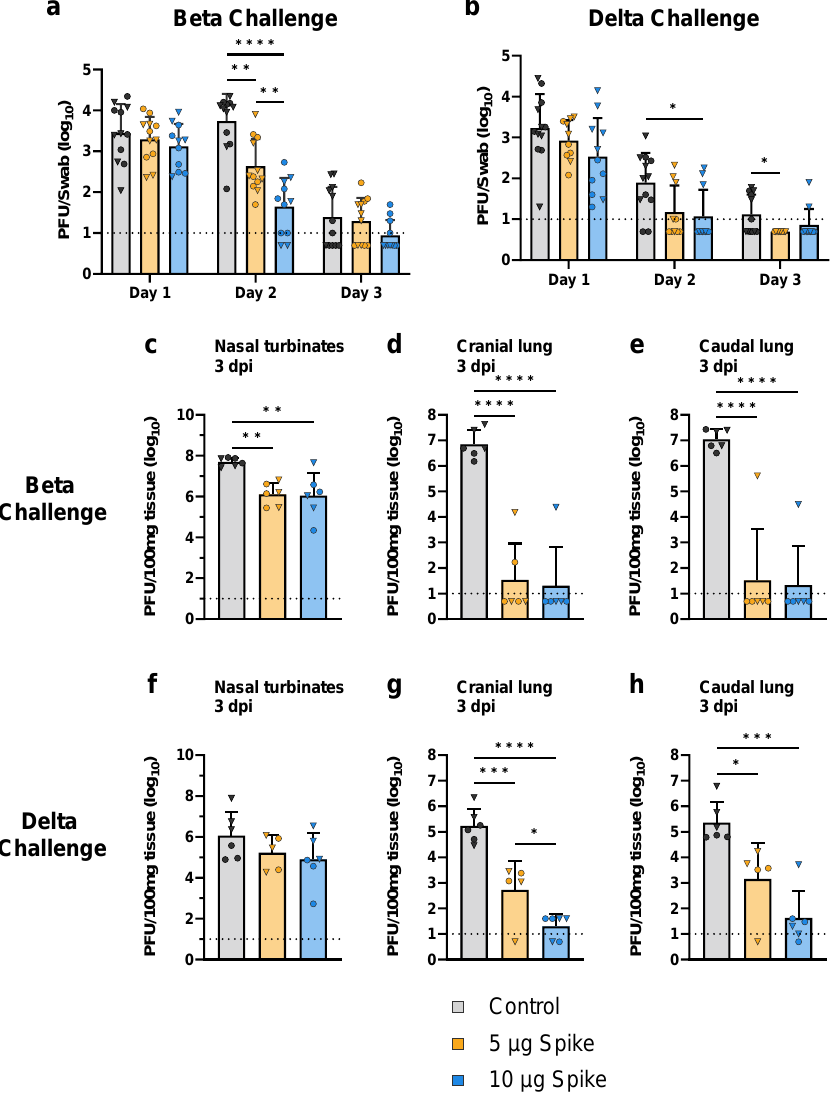
Figure 5. Viral load in the upper and lower respiratory tract after challenge with SARS-CoV-2. Viral load in the oropharyngeal passages was determined by plaque assay of swab samples collected from hamsters challenged with the ( a ) Beta or ( b ) Delta variant of SARS-CoV-2. Swab samples were collected on each of the first 3 days after challenge. Viral load was also determined by plaque assay of tissue samples collected 3 days post infection (dpi) from hamsters challenged with the ( c – e ) Beta or ( f – h ) Delta variant. Sampled tissues include the ( c , f ) nasal turbinates, ( d , g ) cranial lung, and ( e , h ) caudal lung. Values for individual animals are presented as either circles ( ● ) for females or triangles ( ▼ ) for males. Dotted line indicates lower limit of detection. Data are mean + SD. Results were ana- lyzed by two- way ANOVA with Tukey’s multiple compari sons test in ( a ) and ( b ), and by one-way ANOVA with Tukey’s multiple comparisons test in ( c – h ), with P < 0.05 considered significant. * P < 0.05, ** P < 0.01, *** P < 0.001, **** P < 0.0001.